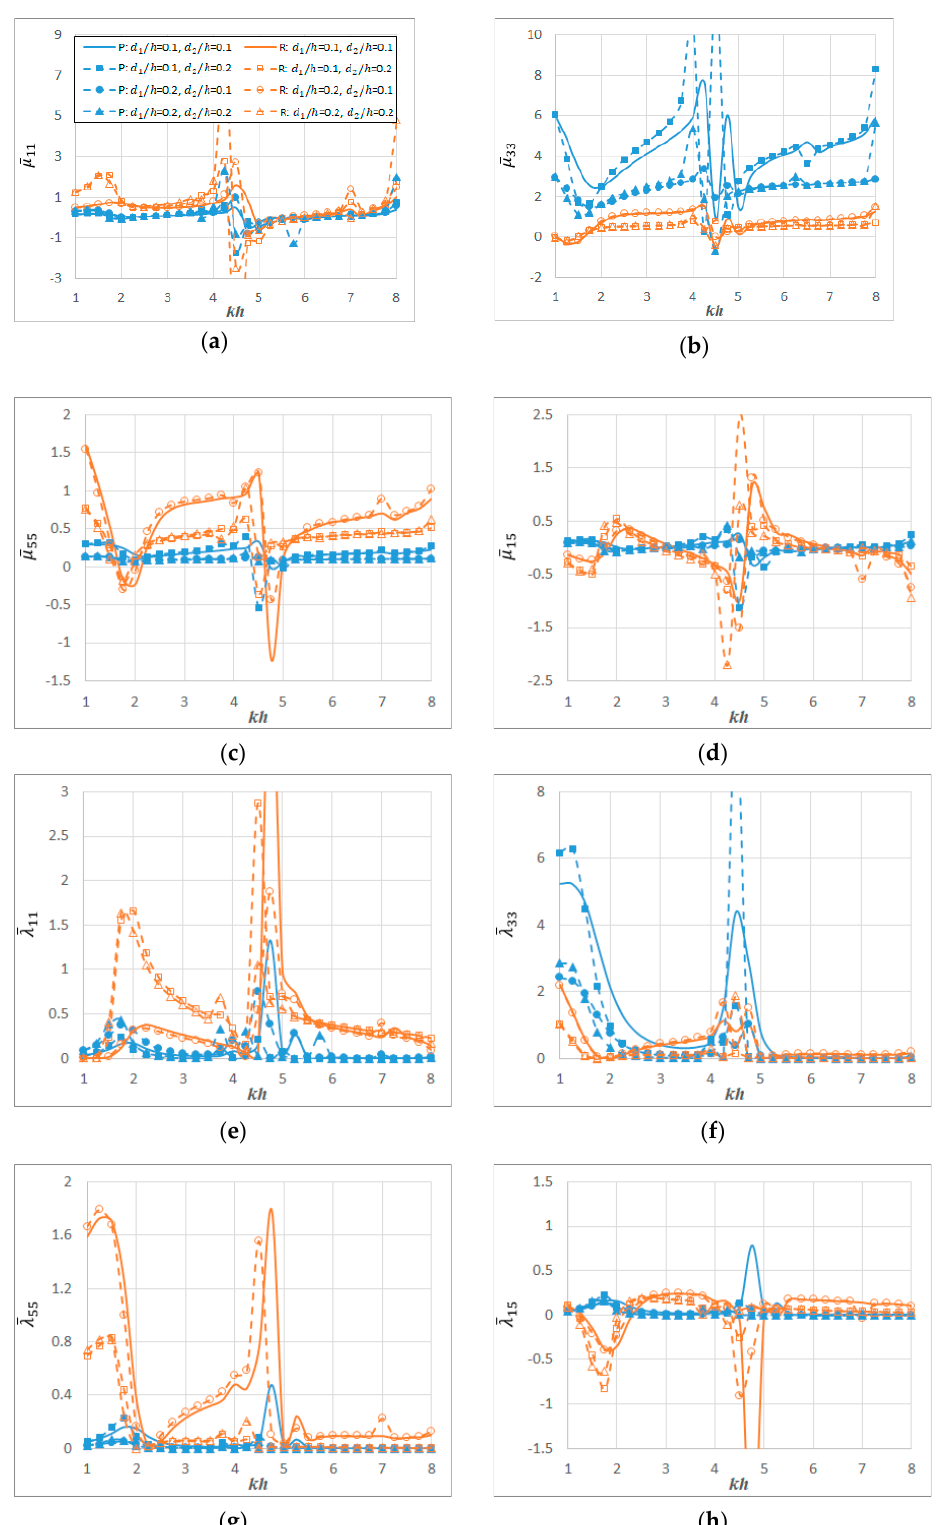
Figure 7. Normalised wave exciting forces and RAOs for floating hexagonal platforms and ring structures with various draft ‐ to ‐ water depth ratios: ( a ) surge force; ( b ) heave force; ( c ) pitch mo ‐ ment; ( d ) RAO for surge; ( e ) RAO for heave; ( f ) RAO for pitch.